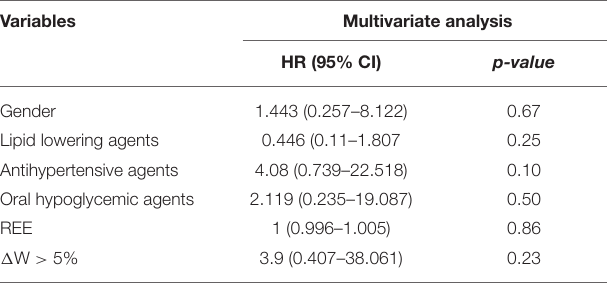
TABLE 2 | Cox proportional hazards models for the risk of Metabolic Syndrome/Type 2